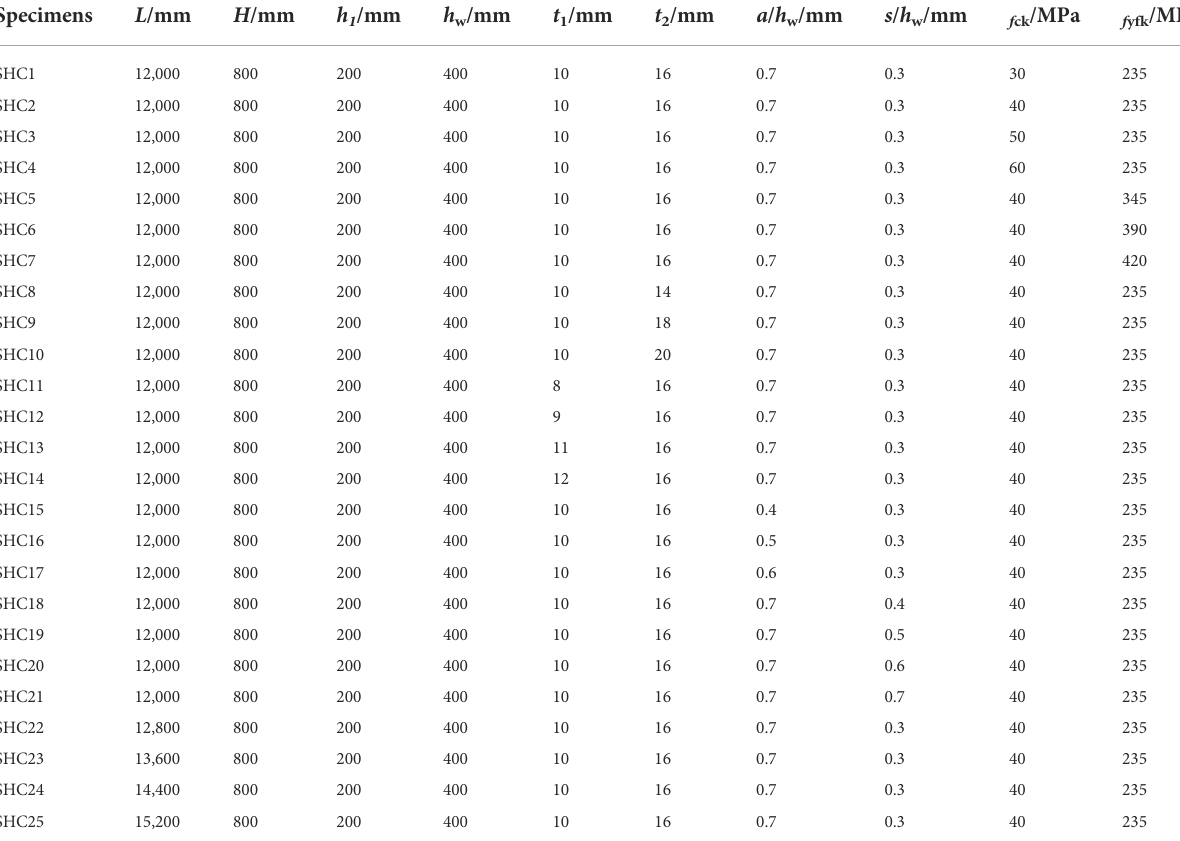
TABLE 1 The main parameters of 25